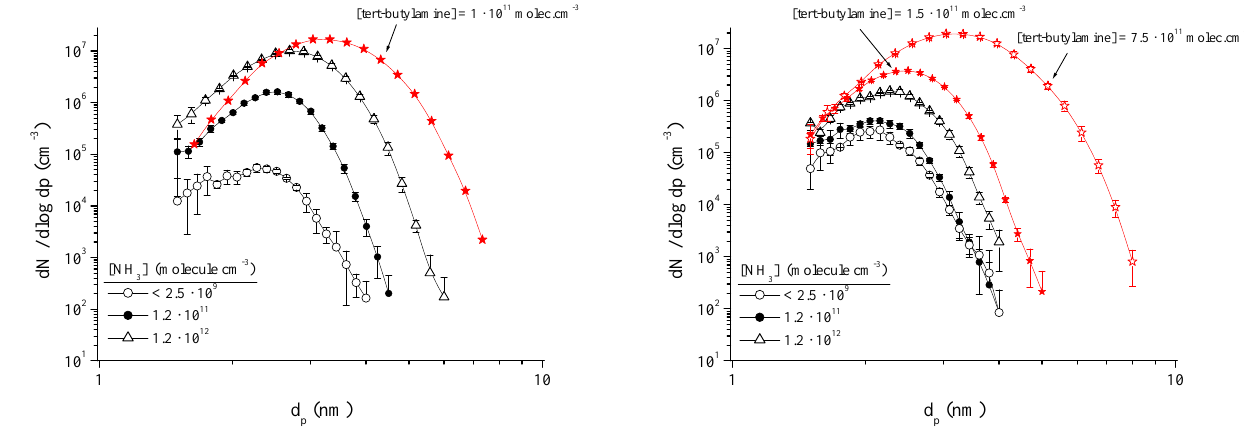
Fig. 11b. Particle size distributions obtained in absence or presence (1.2 × 10 11 or 1.2 × 10 12 moleculecm − 3 ) of NH 3 addi- tions or tert-butylamine (1.5 × 10 11 or 7.5 × 10 11 moleculecm − 3 ); total gas flow: 30lmin − 1 STP. Relative humidity: 47%; [H 2 SO 4 ]=2 × 10 8 moleculecm − 3